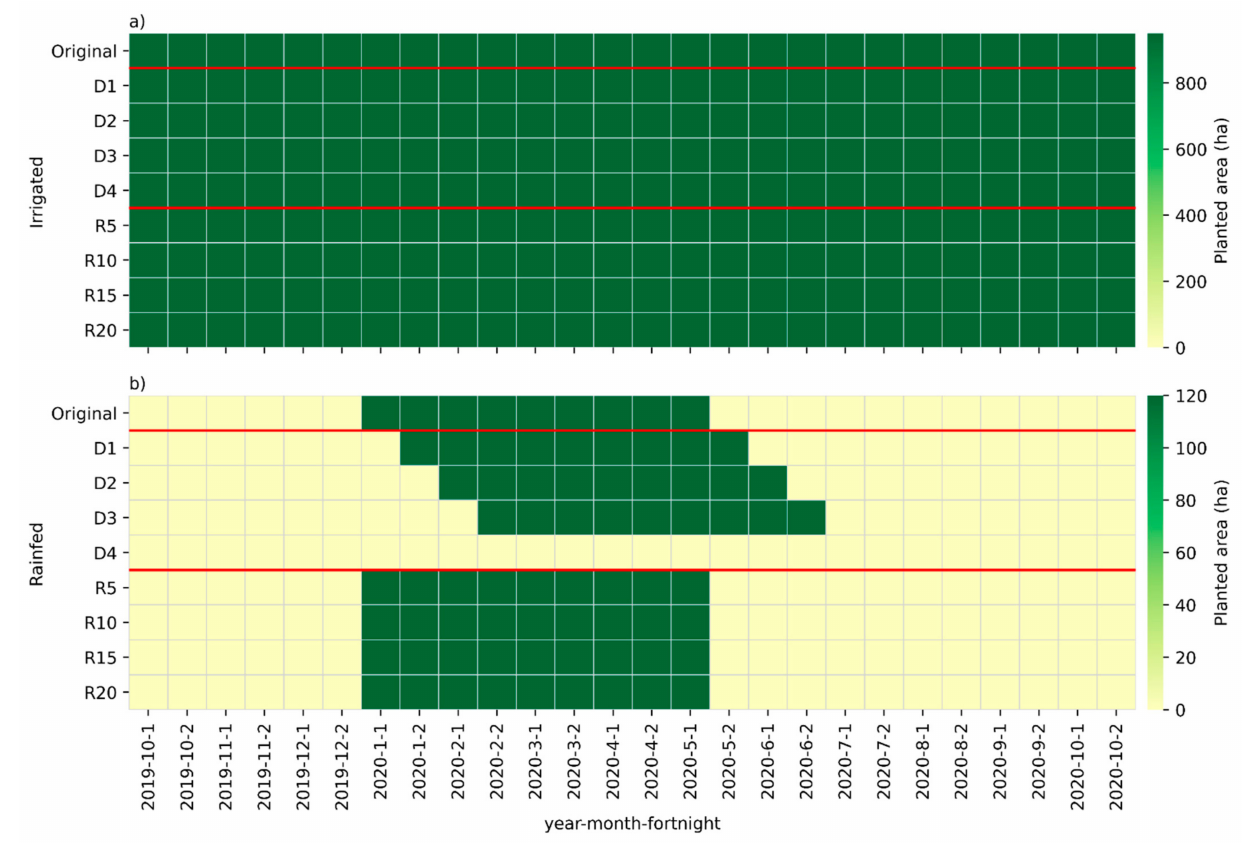
Figure 4. Planted area, in hectares, recommended by LPM application for irrigated areas of Sama farm considering rainfall delay and reduction scenarios.